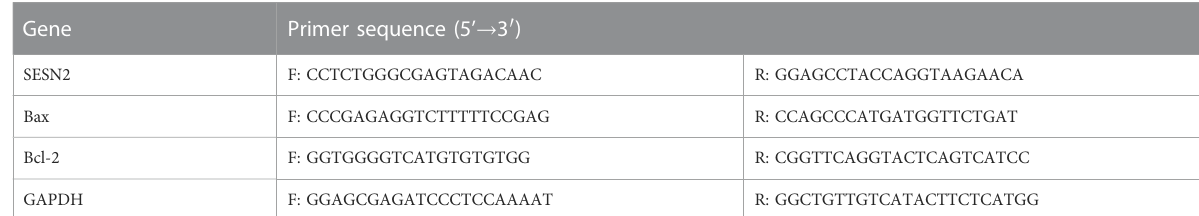
TABLE 1 The primers used in the study.